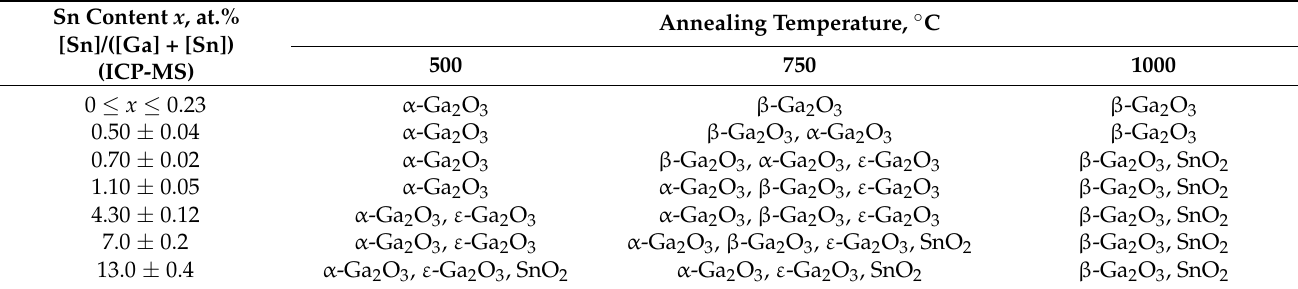
Table 1. Phase composition of Ga 2 O 3 (Sn)